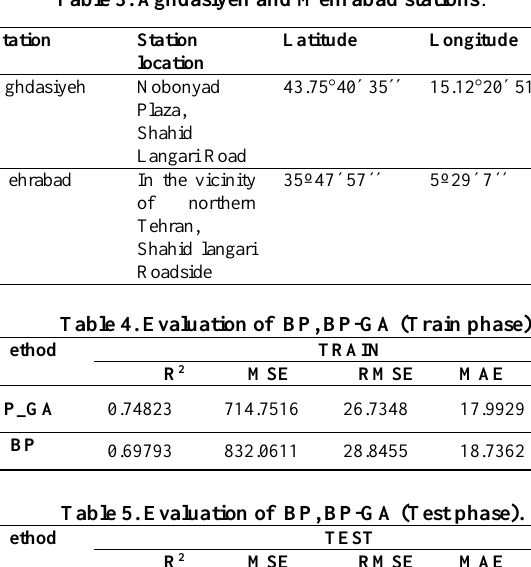
Figure 5. Distribution of test data in the BP. Table 6. Comparison of previous studies and proposed